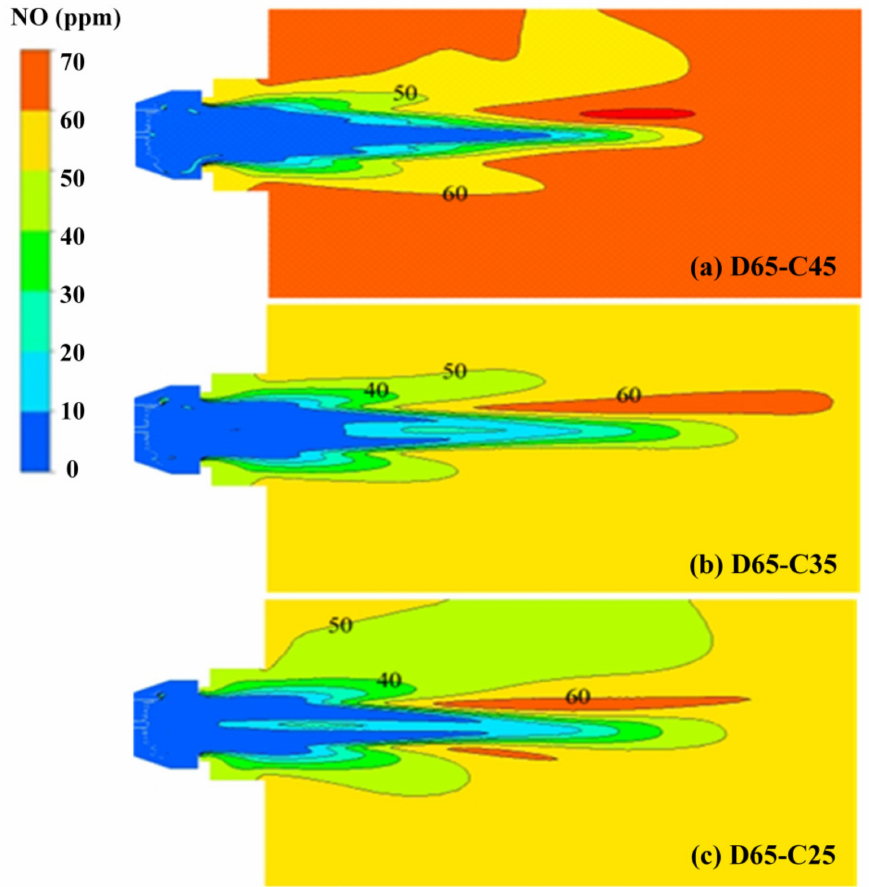
Figure 22. NO x local distribution of D65-C45, D65-35, and D65-C25 on the central cross